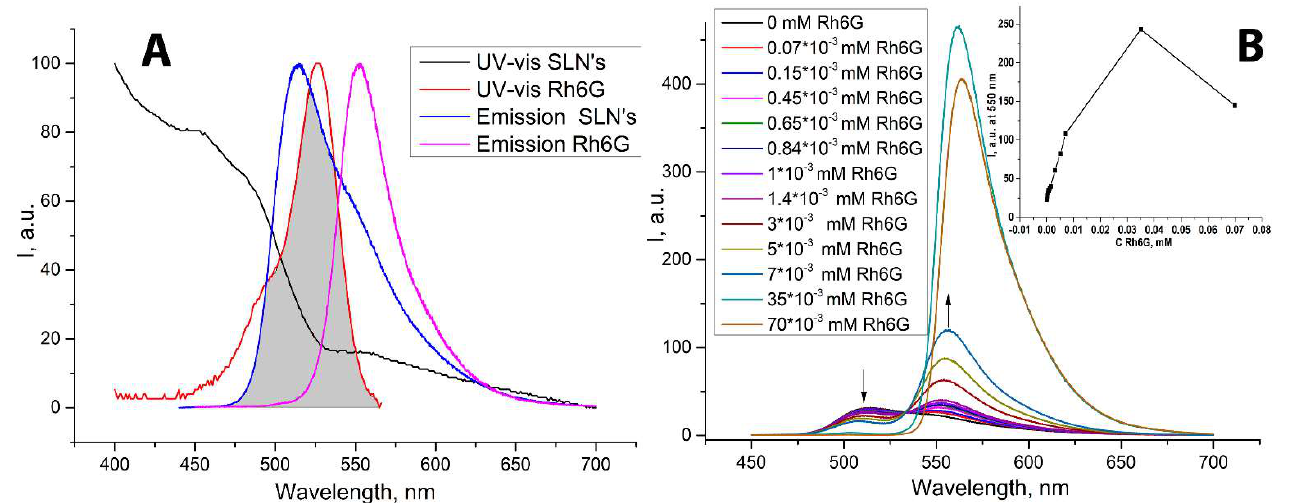
Figure 5. Normalized absorption and emission spectra of SLNs and Rh6G ( A ), emission spectra of SLNs (1 mg/mL) in the presence of various Rh6G concentrations (0.07 μM–0.07mM) ( B ). All emission spectra were registered using λ ex = 430 nm.